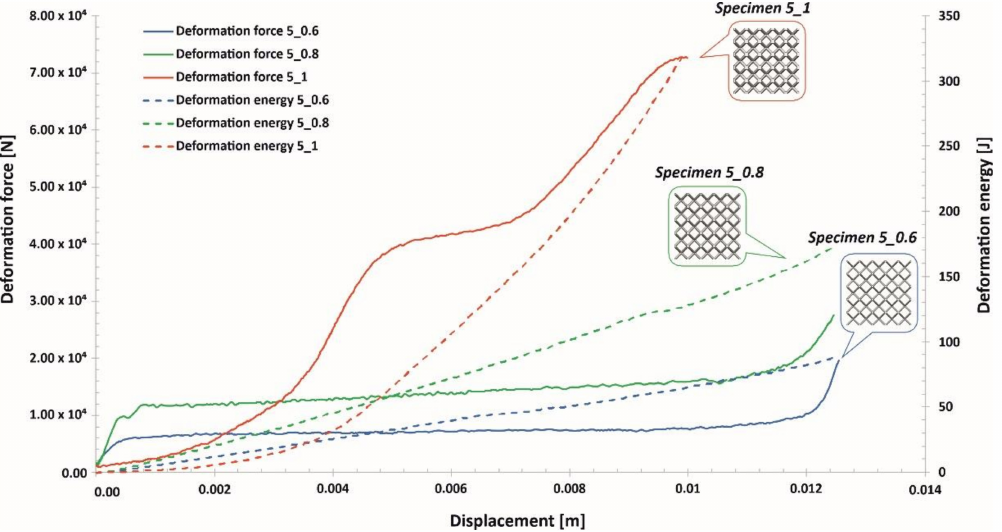
Figure 21. Deformation force and energy plots determined for lattice structures with an elementary unit cell equal to 5 mm under dynamic